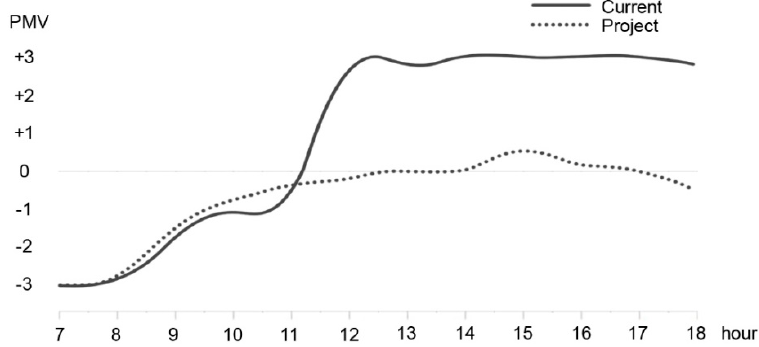
Figure 10. Predicted mean vote (PMV) trend—Representative day.